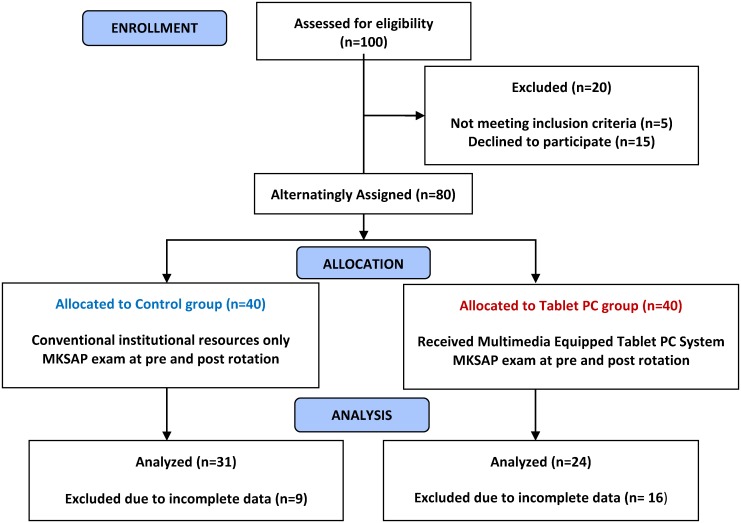
Participant flow.